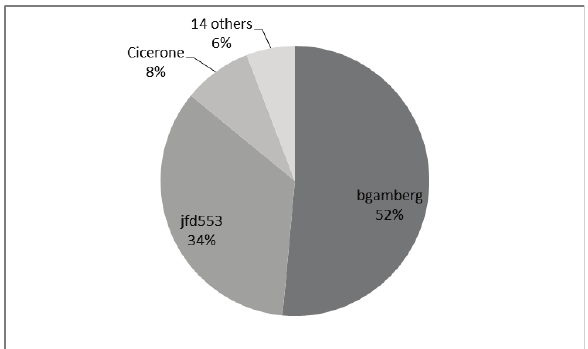
Figure 2: Percentage of contributions of individual OSM users in the test area.